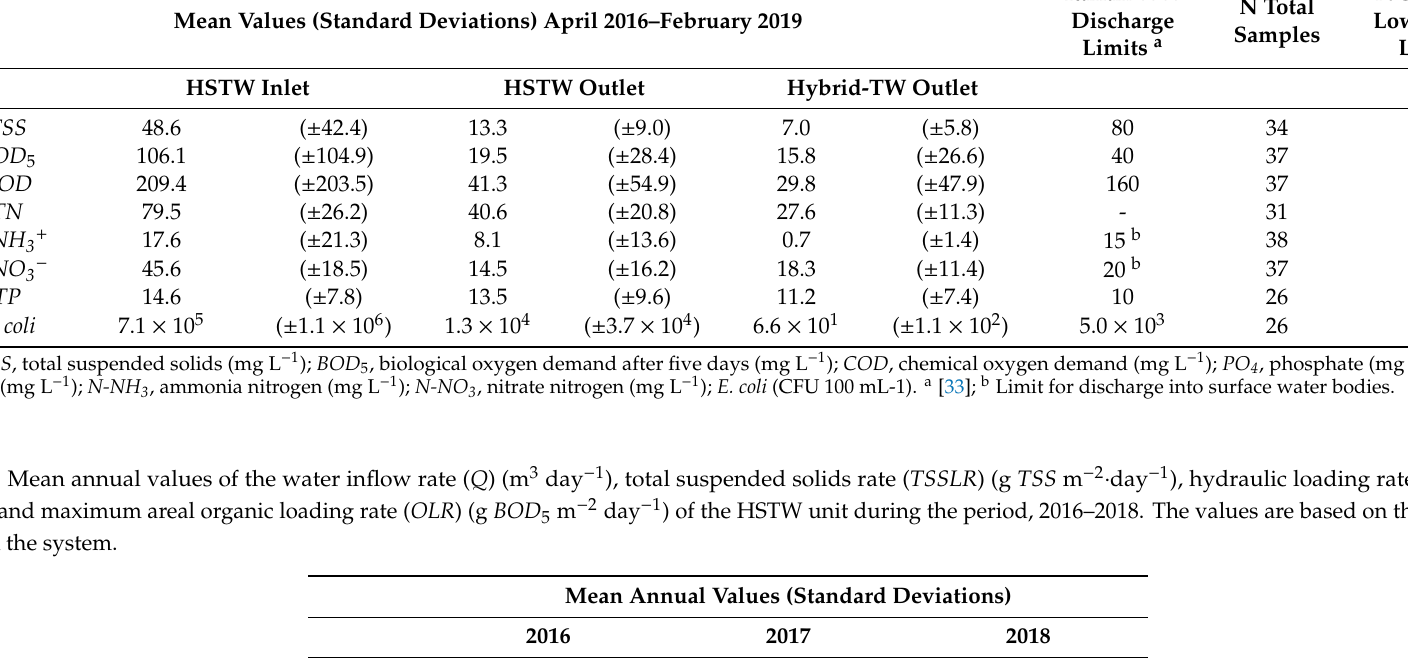
Table 5. Mean values of the physical–chemical (mg L − 1 ) and bacteriological (CFU 100 mL − 1 ) parameters at the HSTW system inlet and outlet and at the hybrid treatment wetland (TW) outlet during the operation period, April 2016–February 2019. Mean Values (Standard Deviations) April 2016–February 2019